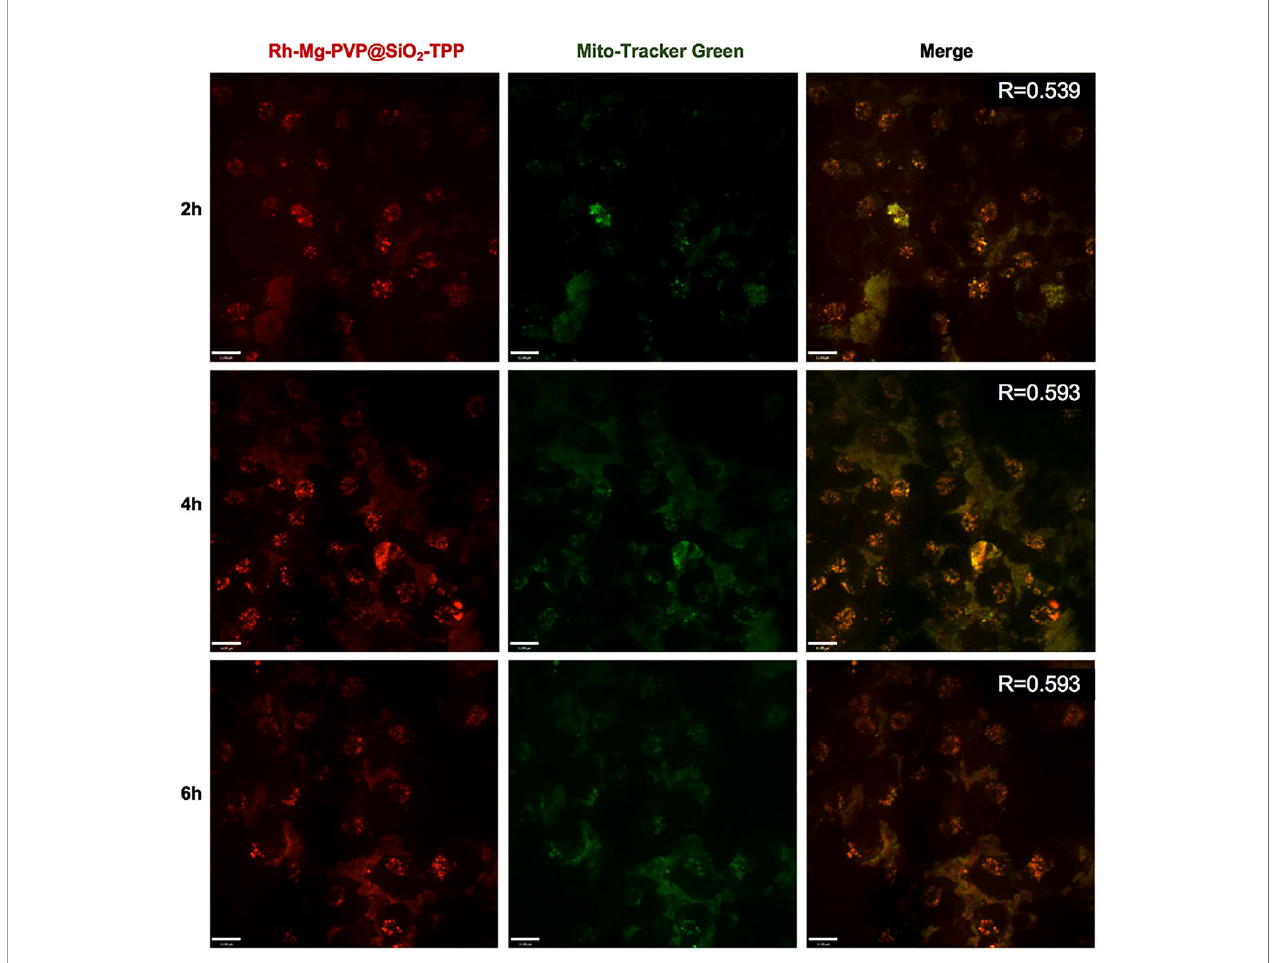
FIGURE 4 | Co-localized images of live Neruo-2a cells incubated with 200 m g ml − 1 Rh-Mg-PVP@SiO 2 -TPP in DMEM for different times at 37°C and then incubated with MitoTracker Green for 10 min at 37°C. Red channel for Rh-Mg-PVP@SiO 2 -TPP NPs ( l ex = 561 nm), green channel for commercialized MitoTracker Green ( l ex = 488 nm), co-localization of green and red channels. Scale bar represents 11 m